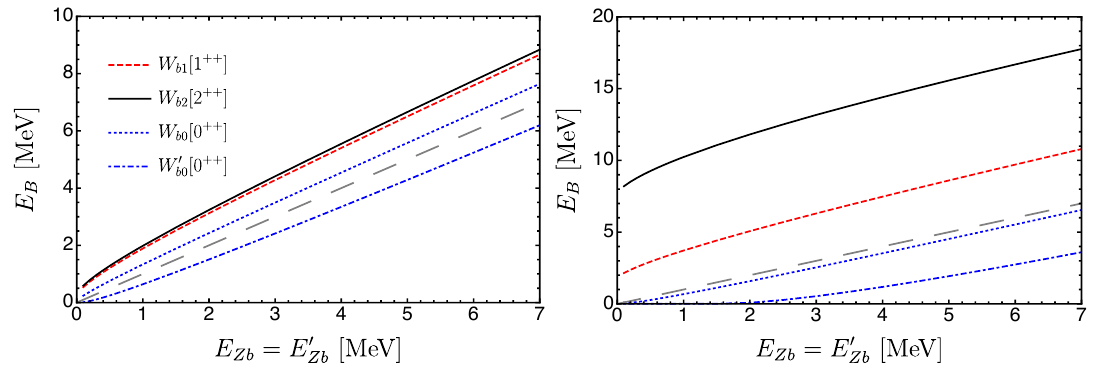
Figure 3 . Dependence of the binding energies of the W bJ ’s on the input used for the binding energies of the Z b ’s for the purely contact interaction (the (cid:12)rst plot) and for the full theory, including the OPE and OEE (the second plot). To guide the eye, the (equal) binding energies of the Z b ’s are shown as the grey dashed lines. The results are obtained with the sharp cuto(cid:11) (cid:3) = 1 GeV in the integral equations (3.12).